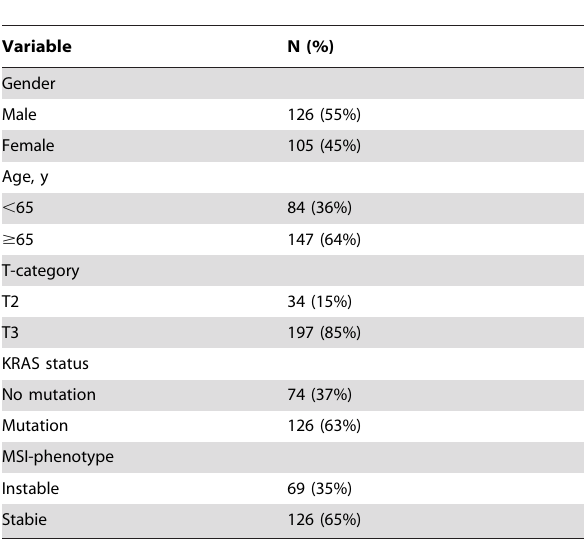
Table 1. Clinical and pathological characteristics of CRC